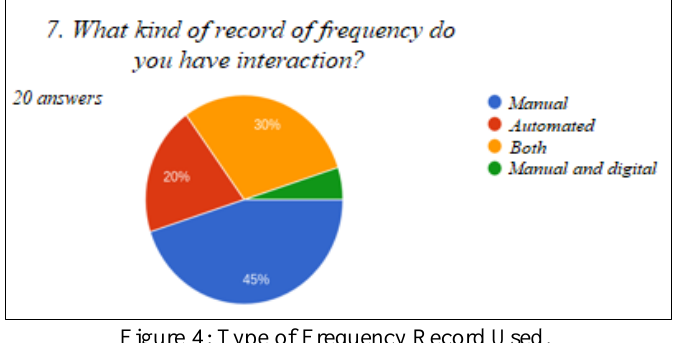
Figure 4: Type of Frequency Record Used.